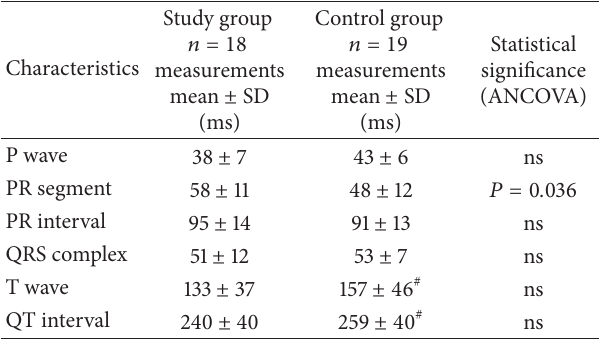
Table 2: Cardiac time intervals of the study group compared to those of the control group at 18–26 weeks of gestation ( 𝑃 value is adjusted for gestational age, gender, and